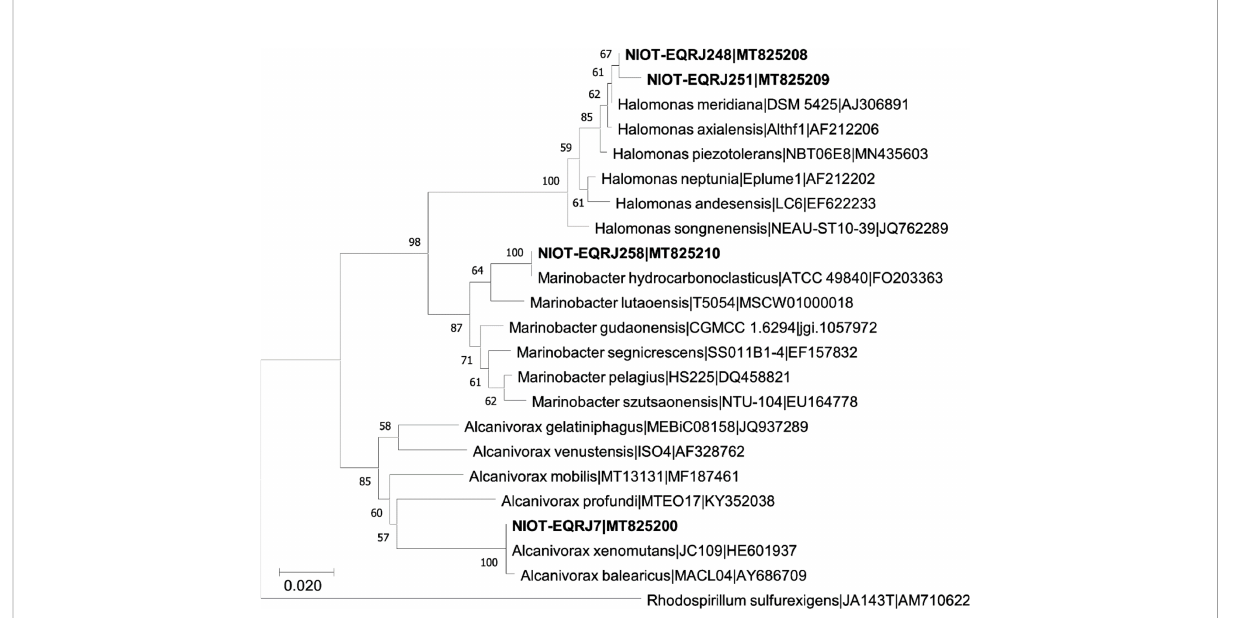
FIGURE 2 Phylogenetic analysis of Alcanivorax xenomutans strain NIOT-EQR_J7, Halomonas sp. NIOT-EQRJ_248 and NIOT-EQRJ_251; and Marinobacter hydrocarbonoclasticus strain